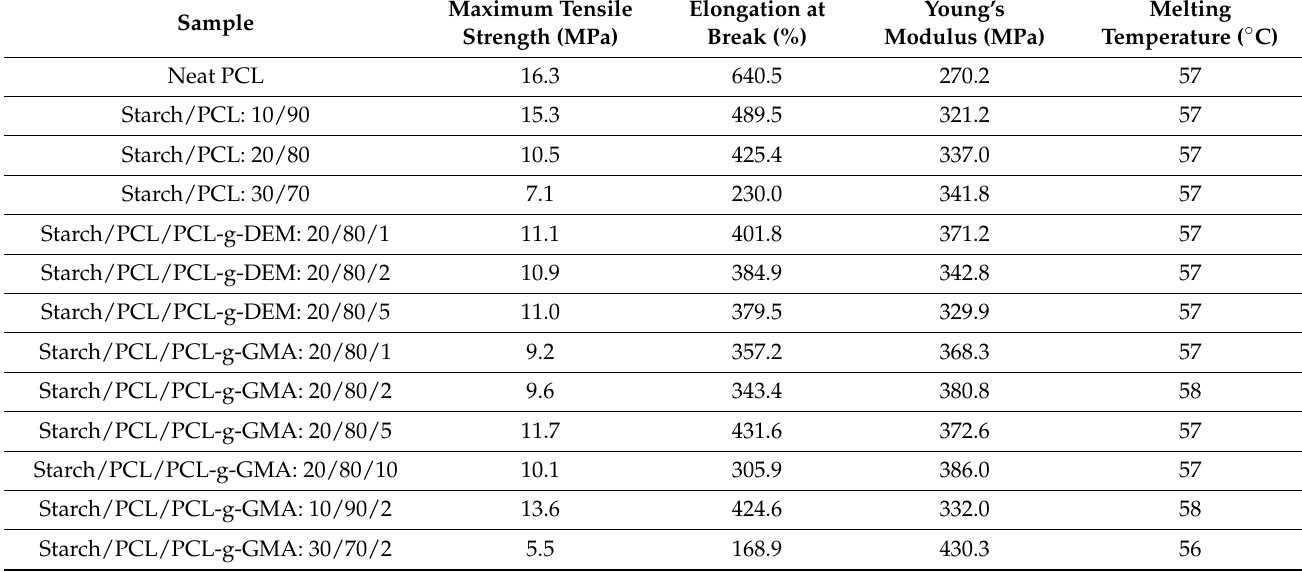
Table 2. Comparison of thermo-mechanical properties of Starch/PCL blends